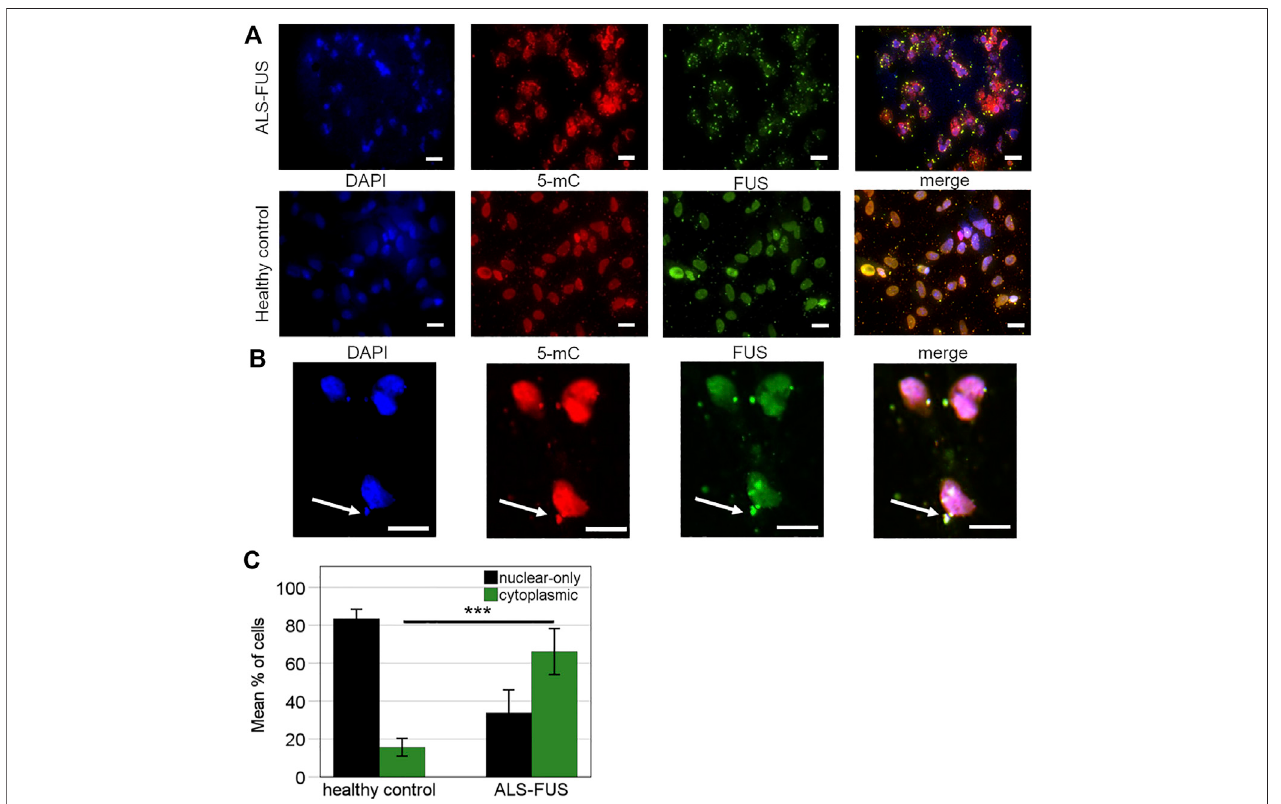
FIGURE 6 | Immuno fl uorescence of ALS pathology, (A) Cytoplasmic retention of mutant FUS . FUS immunostaining in FUS mutant and control MNs. Staining patterns for FUS (green), 5mC (red, 5th cytosine methylation) are shown individually and in the merged images together with DAPI-stained nuclei (blue). Scale bars (cid:2) 20 μ m, n (cid:2) 3per conditionand n (cid:2) 3percellline, (B) ALSmotorneuronsexhibitcytoplasmic FUS aggregates, allofwhichshowperceived proximity with5-mC(arrows). Scalebar (cid:2) 20 µm, (C) Percentageofcellsobservedwithnuclear-only (darkbars)andanycytoplasmic(greenbars) FUS staining.Statisticalinferencesweredrawn from unpaired t -test and illustrated as mean ± SEM. Results were regarded as statistically signi fi cant with *** p < 0.001, n (cid:2) 3 per condition and n (cid:2) 3 per cell line.